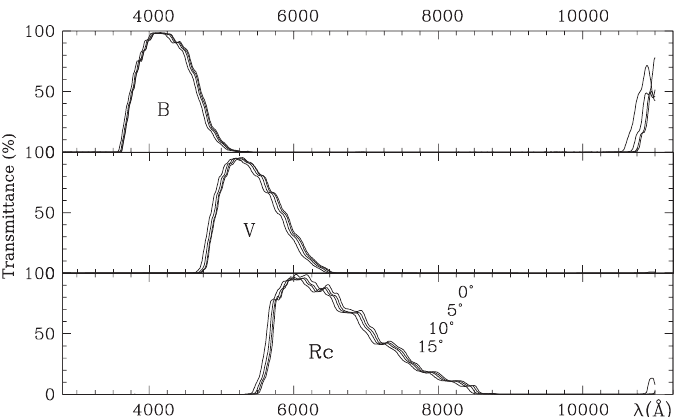
Fig. 6. Dependence of the filter transmittance on the angle of incident light for the Astrodon filters which are in use at the ANS Collaboration telescope R122 (the quoted angles are deviations from the normal incidence).